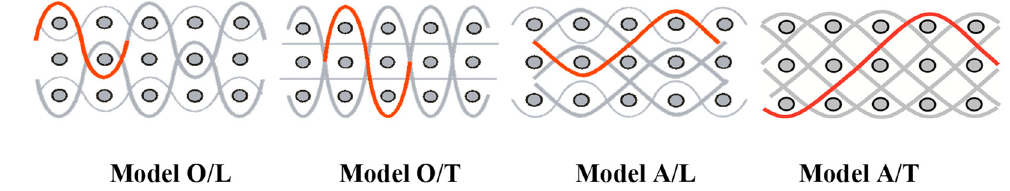
Figure 1. Structural models of multilayer woven